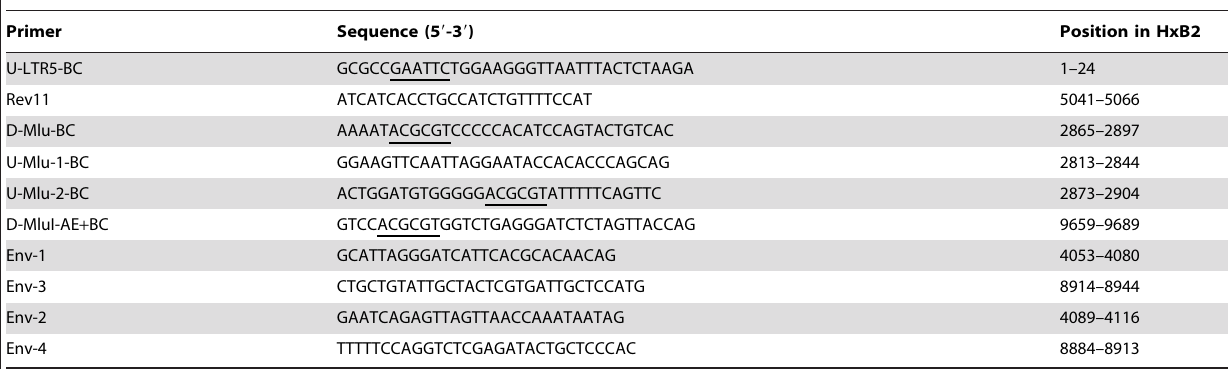
Table 1. Primers for constructing infectious clones.